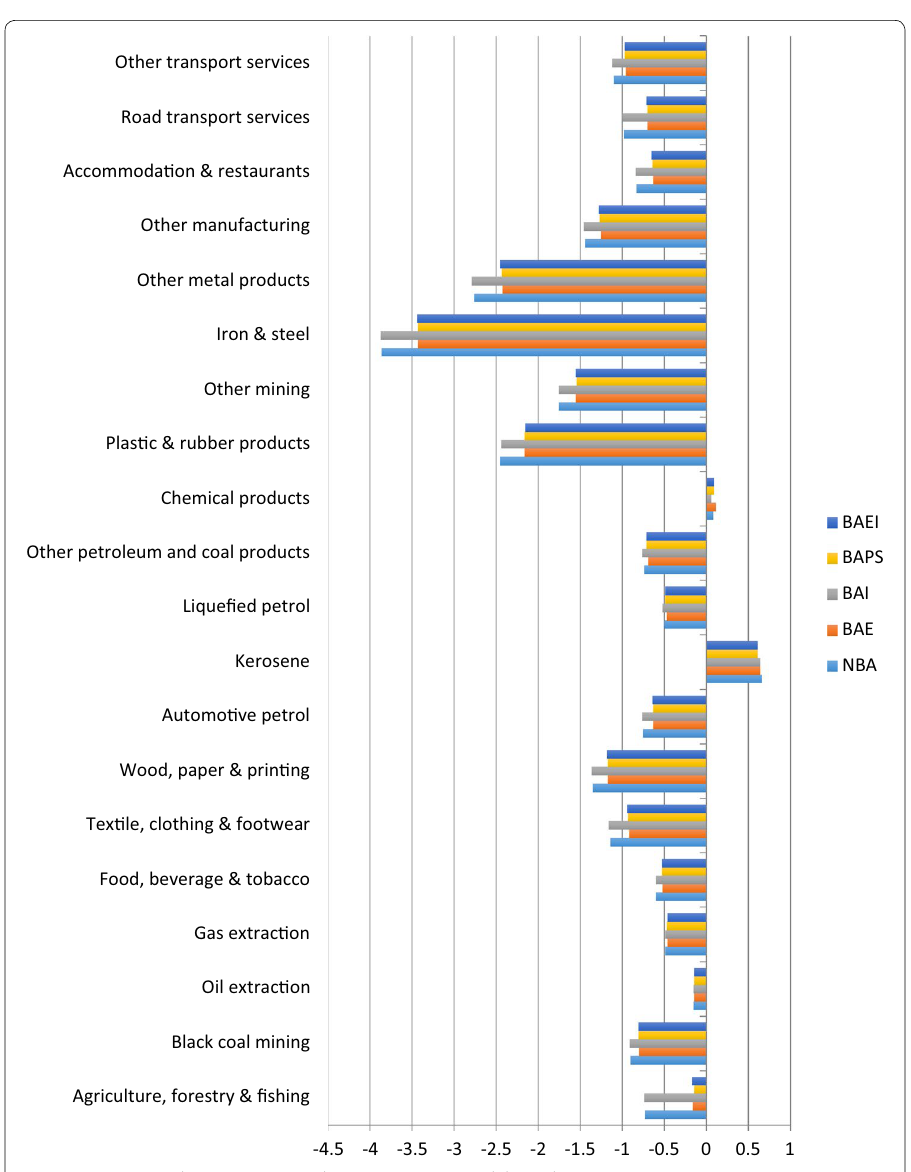
Fig. 7 Percentage change in outputs by sector. Source Model